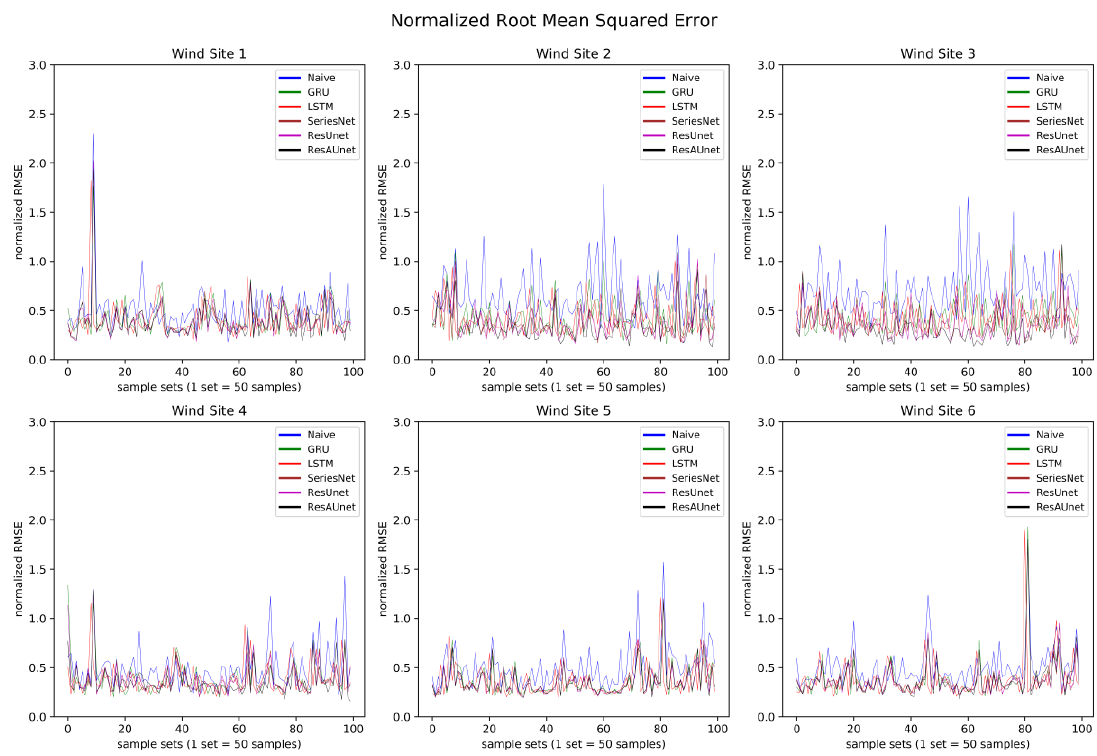
Figure 19. NRMSE of the six models for different wind sites at each prediction step (sample set).